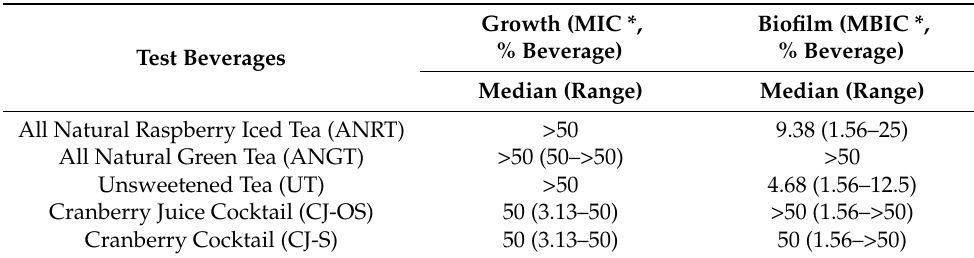
Table 2. Inhibition of growth and biofilm formation of children’s supragingival plaque bacteria